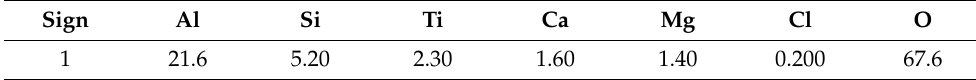
Table 2. Elemental composition (at.%) of the sample point signed in Figure